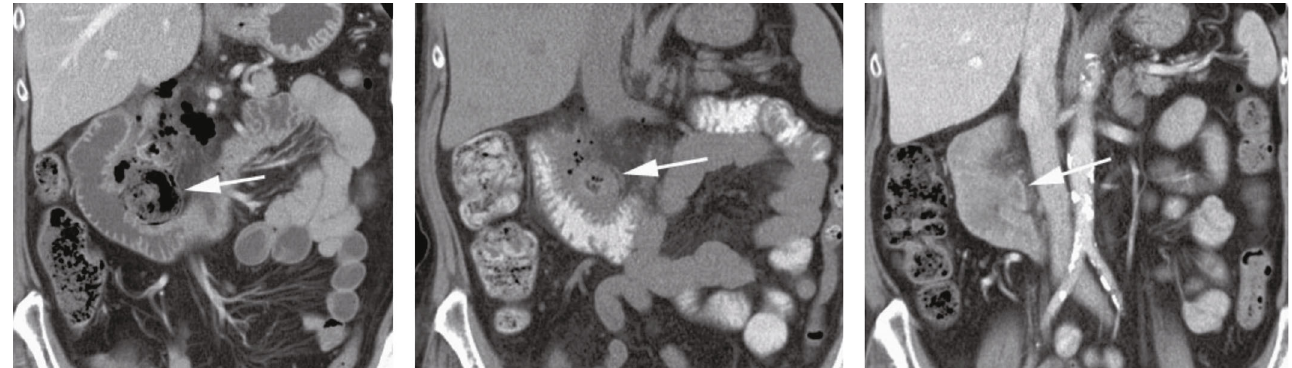
Figure 3: Duodenal diverticulitis. Axial CT scan shows in fl amed diverticulum (arrow) medial to the duodenum (arrowheads). There was also free retroperitoneal air (not shown